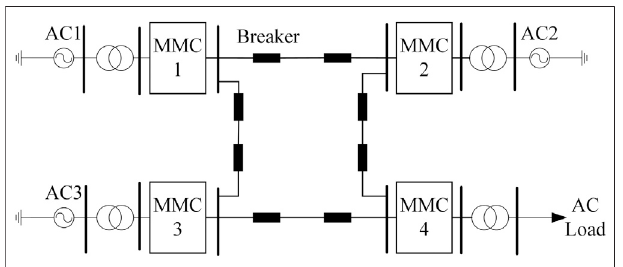
FIGURE 15 | The four-terminal ring grid DC distribution